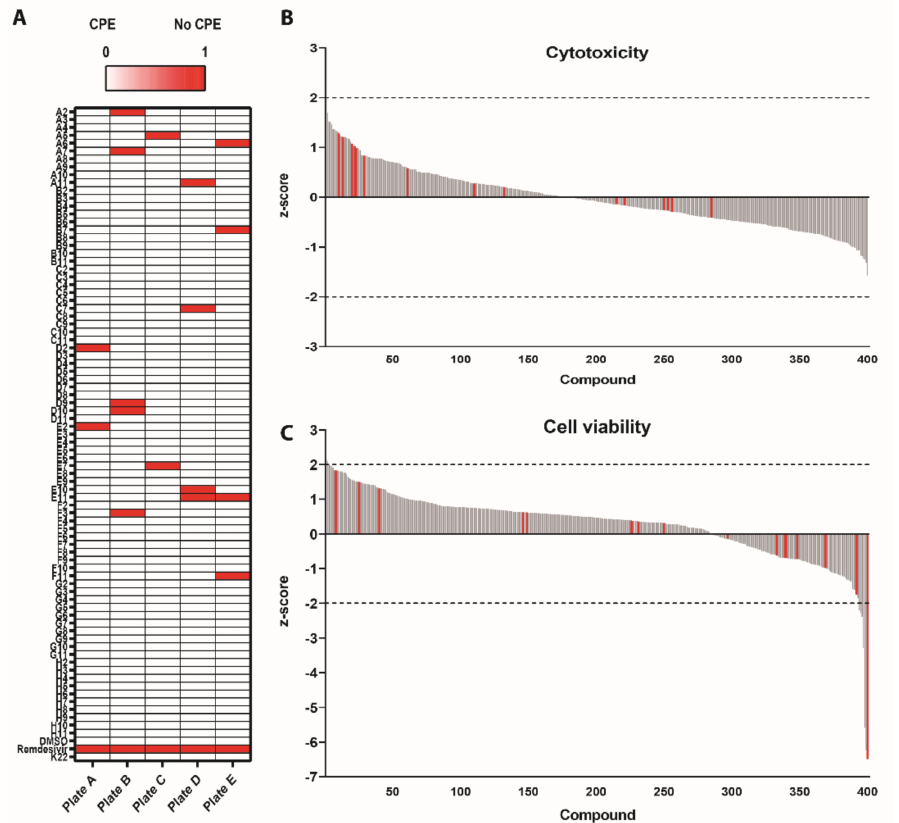
Figure 1. Cell survival upon infection with severe acute respiratory syndrome coronavirus 2 (SARS-CoV-2) ( A ), cytotoxicity ( B ) and viability ( C ) after incubation with pandemic response box compounds. The survival, cytotoxicity and viability were measured after 48 h of incubation on Vero-E6 cells at 37 ◦ C in a humidified incubator with 5% CO 2 . The heatmap shows the position on the plates where survival was observed with a multiplicity of infection (MOI) of 0.01, which was scored from 0 to 1 (0 = cytopathogenic e ff ects (CPE) and 1 = no CPE) ( A ). Calculated z-scores of each individual compound for cell cytotoxicity ( B ) and cell viability ( C ). A confidence interval of 95% (z-score of − 2 or + 2) was used as cuto ff values, which are indicated with gray dashed lines. Each bar represents an individual compound sorted from high to low z-scores ( x -axis). The red bars indicate the compounds that showed inhibition of SARS-CoV-2 during the survival screen. Results are shown as mean of two individual experiments performed in two technical